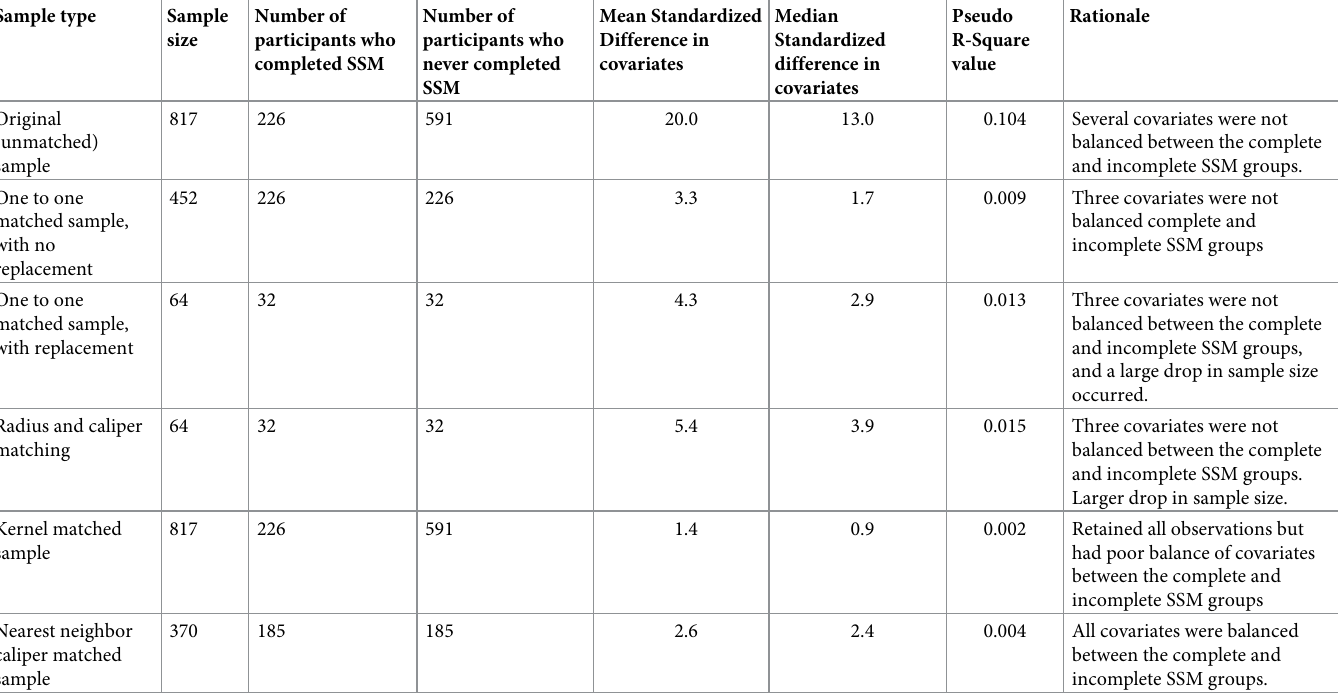
Table 2. Sample sizes, means, standardized differences across all covariates before and after matching, and rationale for choice of matching